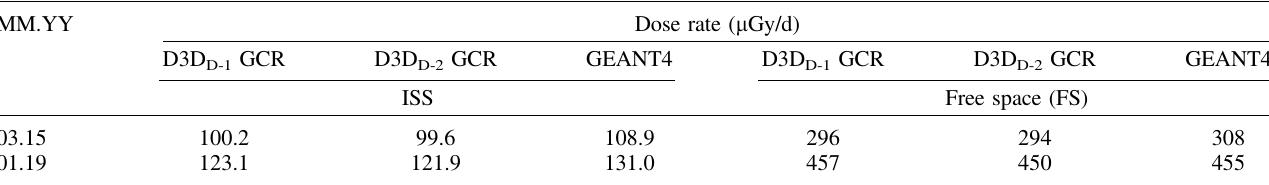
Fig. 13. Calculated contributions to the absorbed dose in Si by different particle species during solar maximum and solar minimum conditions (a) for ISS orbit and (b) for free Table 6. Measured and calculated GCR dose values for solar maximum (March 2015) and solar minimum (Jan 2019) conditions for ISS orbits and for free space.